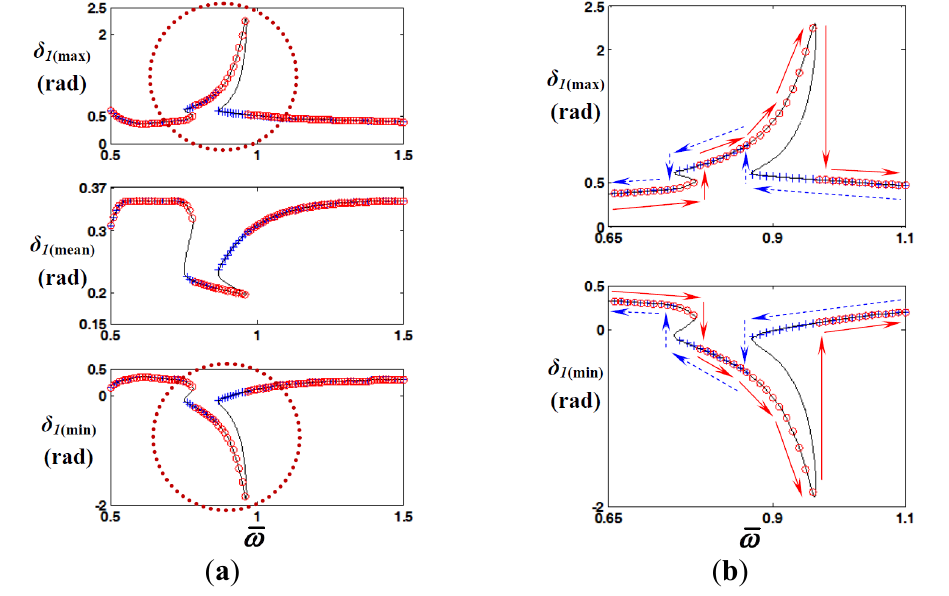
Figure 6. Comparison of HBM ( N max = 12 and ρ = 1) with NS in the frequency domain: ( a ) comparison of max, mean, and min values of   phenomena under the frequency up- and down-sweeping conditions. Key: ━━ , HBM;  , NS by frequency up-sweeping;  , NS by frequency down-sweeping; numerical solution under frequency up-sweeping; ·······› , flow of numerical solution under frequency down-sweeping.